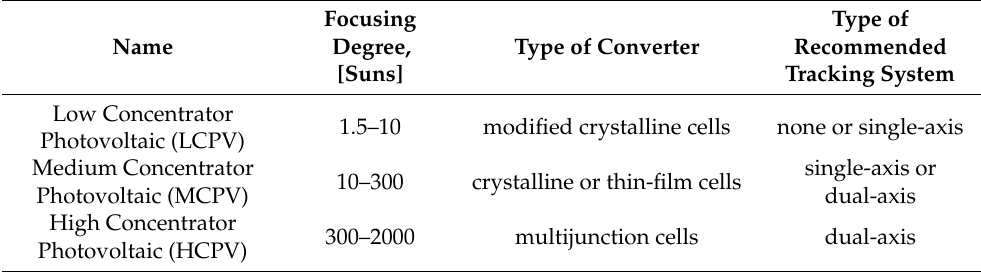
Table 1. Classification of concentric PV cells based on the degree of focusing of solar radiation, compiled based on